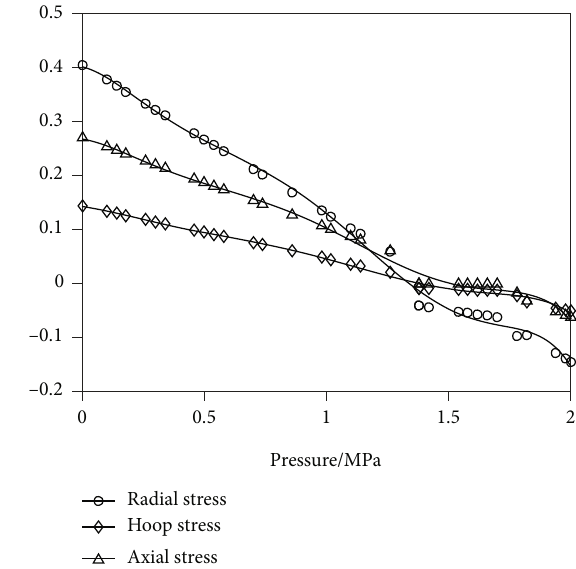
Figure 8: The trend of stress in three directions with